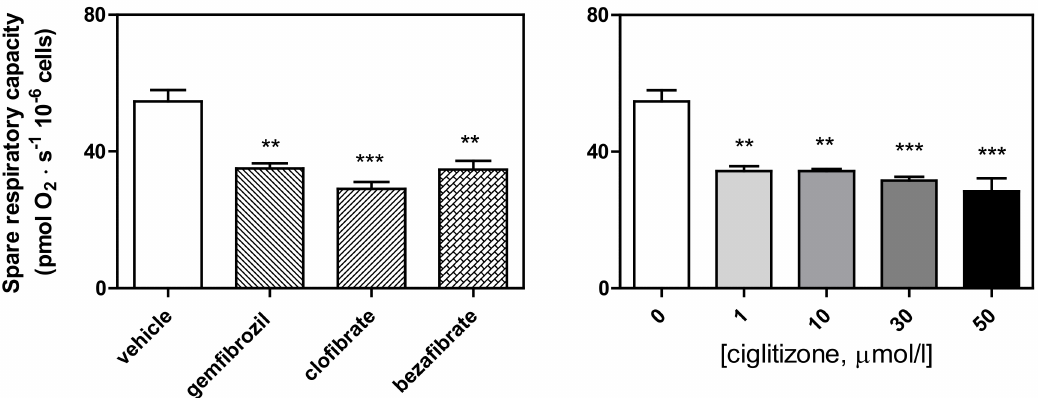
Figure 8. Spare respiratory capacity (calculated by subtracting the basal respiration from the maximal respiration in the presence of ATP) of the HepG2 cells treated with different PPAR ligands (** p < 0.01, and *** p < 0.001).